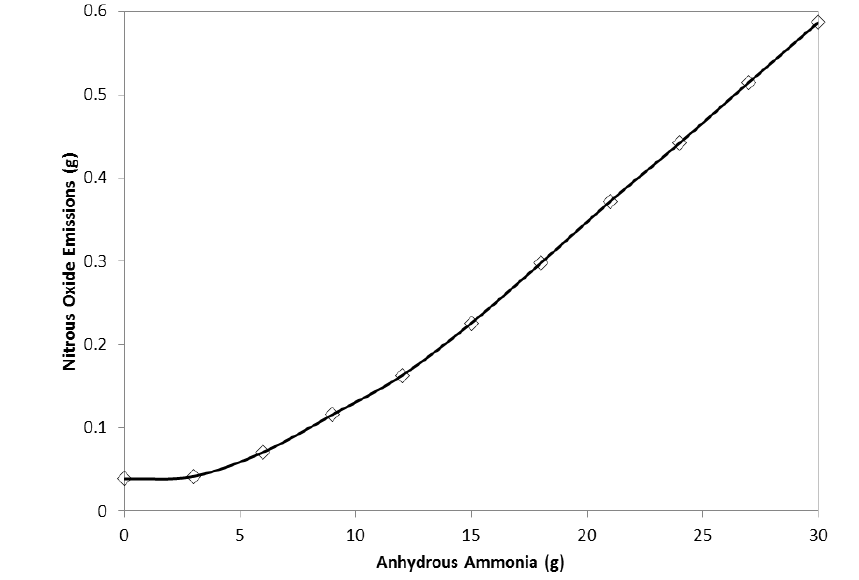
Figure 4. Modeled nitrous oxide emissions per m 2 at various application rates of anhydrous ammonia fertilizer (Data from